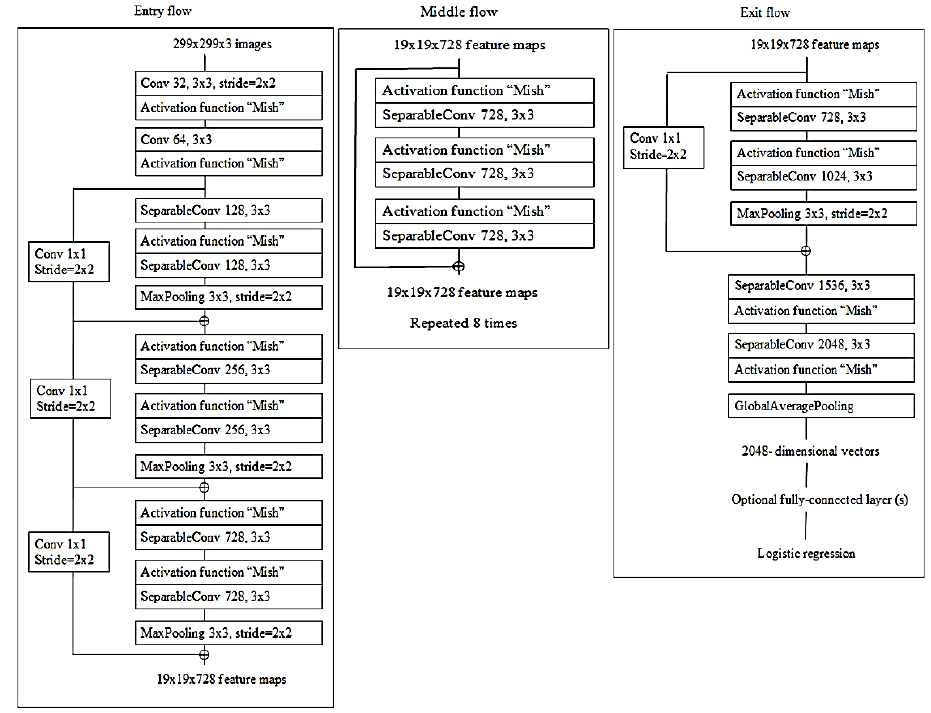
Figure 7. The architecture of Xception.